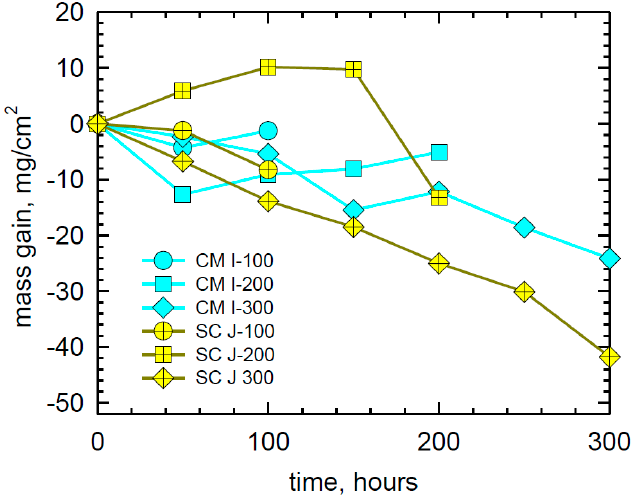
Figure 3. Weight change behavior of duplicate CMSX-4 SXSA samples showing significant losses and